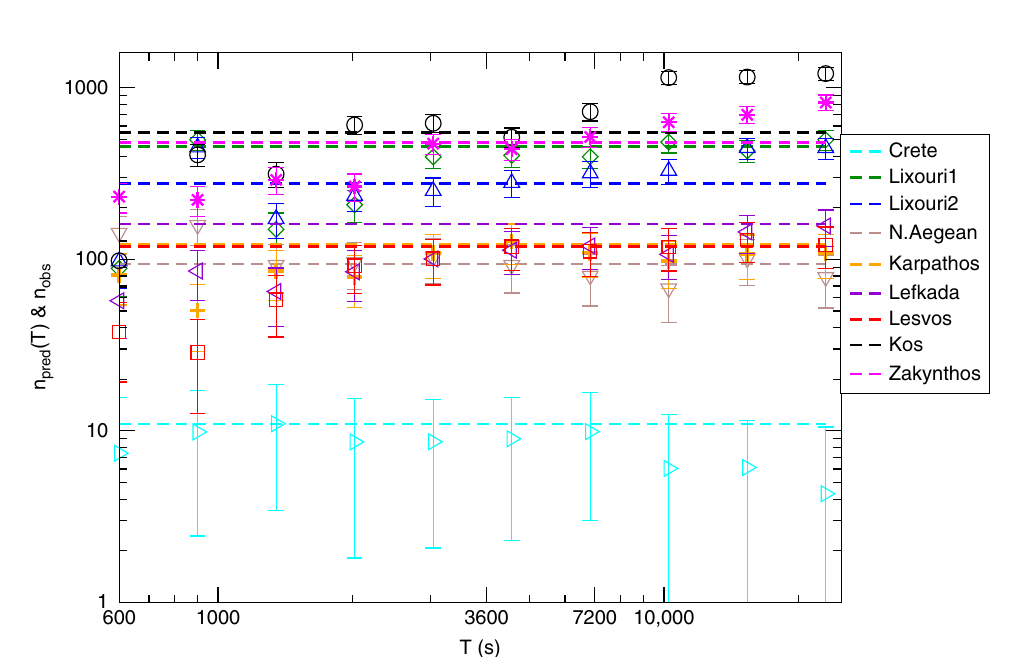
Fig. 6 Short-term test of the method for the recent Aegean earthquakes. We compare the number of observed and predicted aftershocks with μ i > μ M − 3 in the testing period [ t in , t f ], with t in = 2 h and t f = 72 h except for Crete where t f = 48 h and for Karpathos where t f = 54 h. Open symbols represent the value of n pred ( T ) for different values of the testing period T . The error bars correspond to statistical fl uctuations in the number of expected aftershocks for fi xed K and c values. Dashed horizontal lines represent n fi ed aftershocks according to the method described in ref. 8 . Different obs , i.e. the number of identi symbols and colors are used for different mainshocks (see